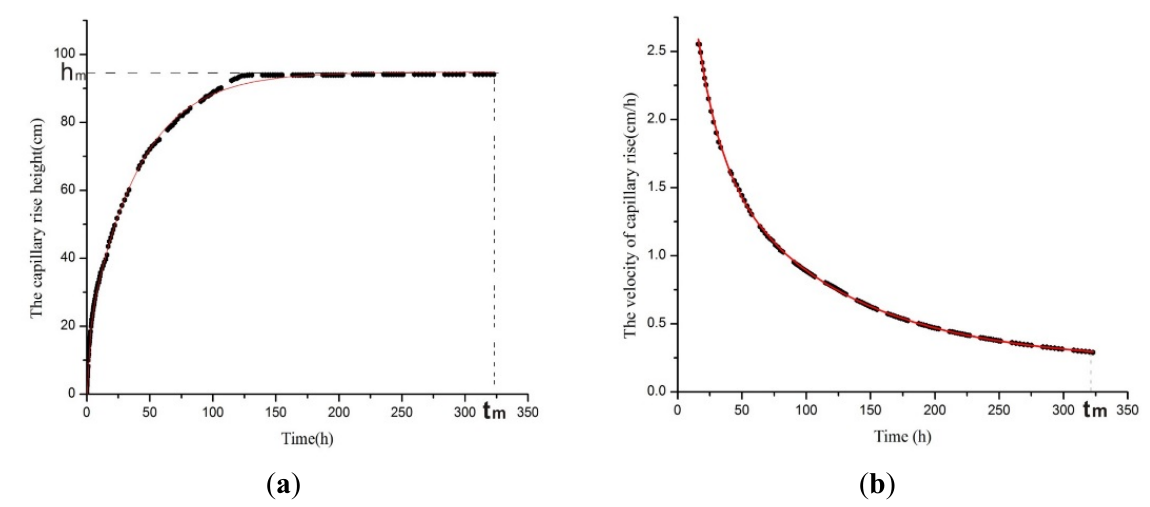
Figure 4. Schematic diagram of the capillary rise height ( a ) and the velocity of capillary rise ( b ).